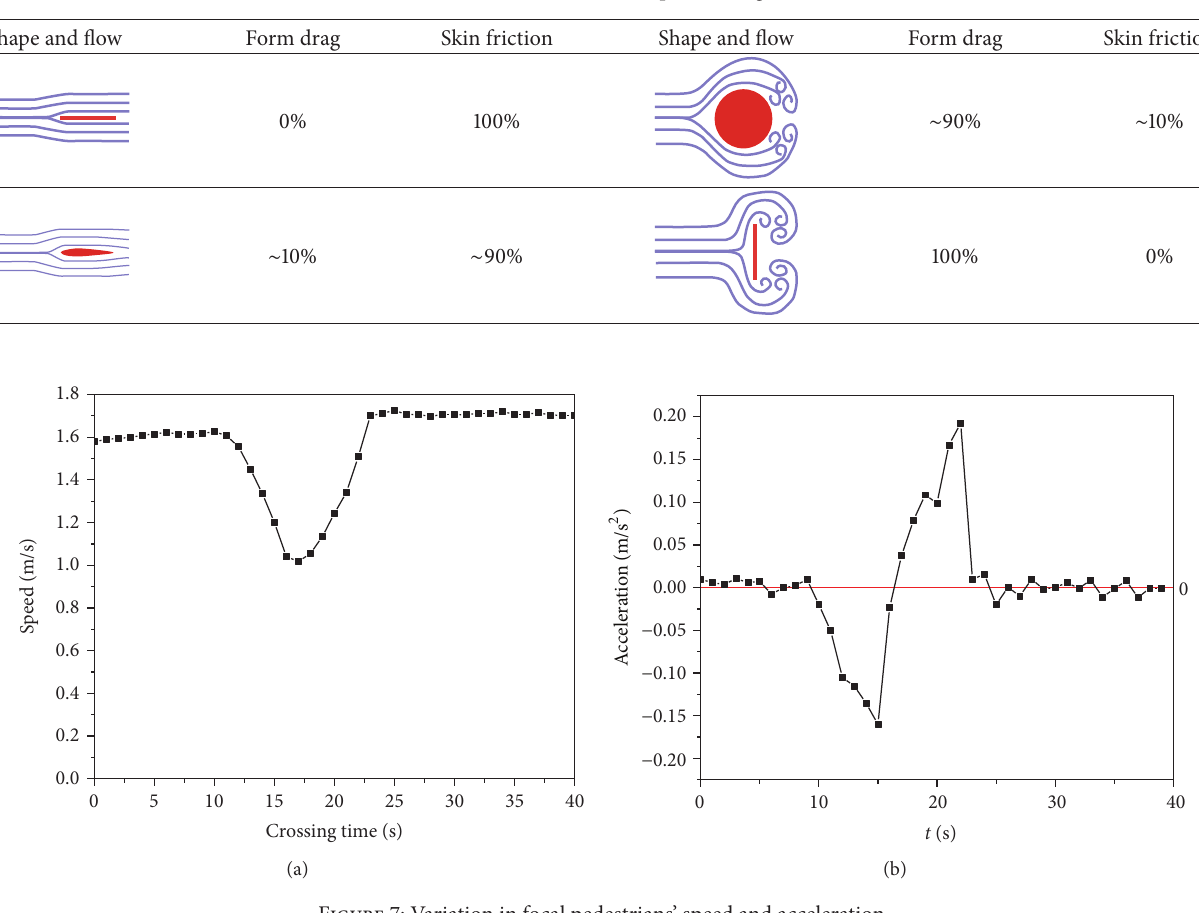
Table 2: Relation between shape and drag force.